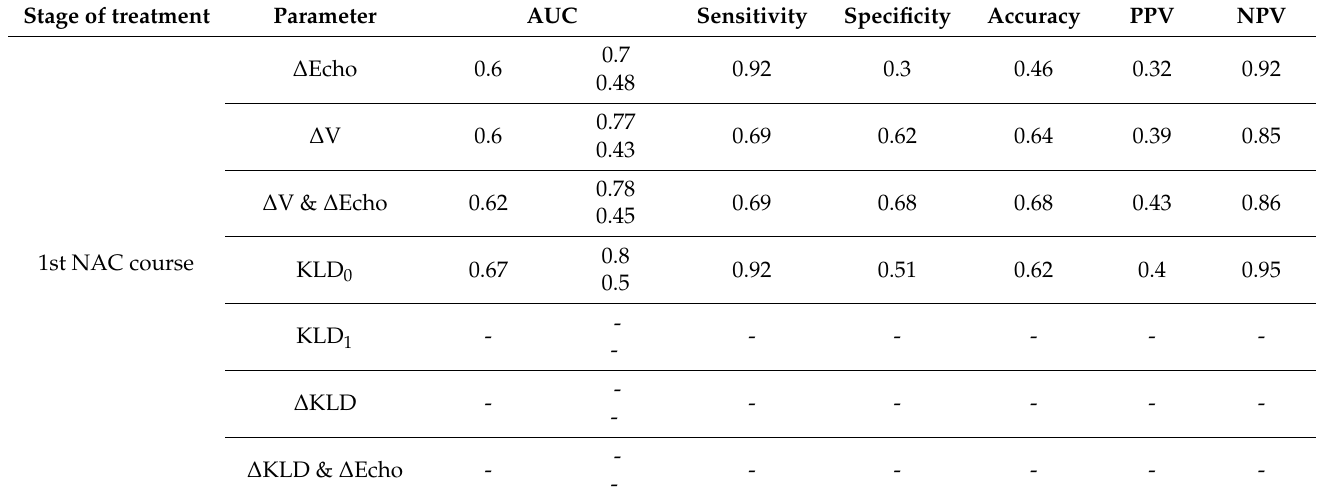
Table A3. Statistical analysis for all measured US parameters (single ∆ Echo, ∆ V, KLD 0 , and KLD 1 , and their combinations ∆ Echo with ∆ V and ∆ Echo with ∆ KLD and in combination) assessed after first, second, third, fourth courses od NAC for RMC ≥